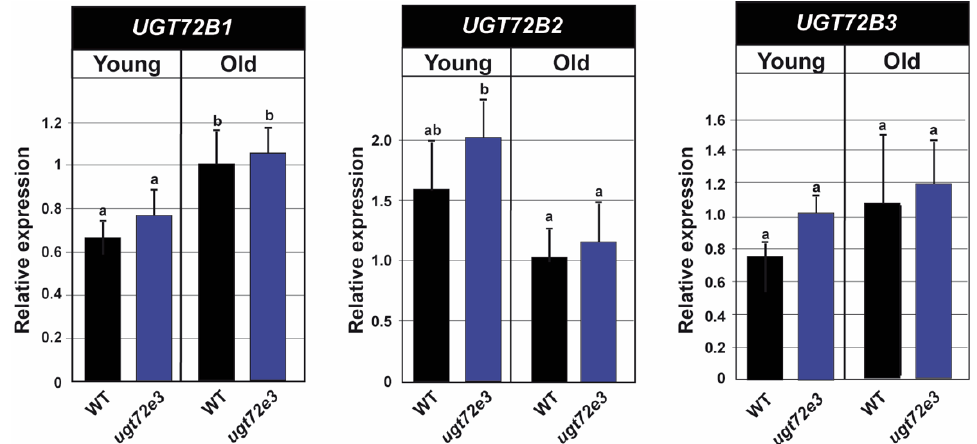
Figure 9. Expression analyses of UGT72B genes in WT and ugt72e3 . RT-qPCR was used to measure the expression of the genes in the old and young parts of the stem. The values are expressed relative to the WT old stem fragments for each analyzed gene. PP2A (AT1G13320) and PEROXIN4 (AT5G25760) were used as internal reference genes. Means (± SD) with the same lowercase letters are not significantly different according to Duncan test ( p -value < 0.05, n = 3).